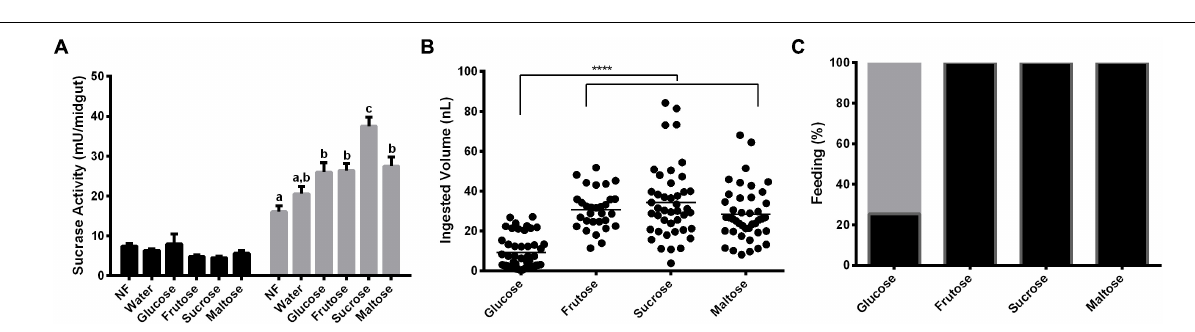
FIGURE 4 | Effect of feeding L. longipalpis females with different 1.2 M mono and disaccharides for 2 days on α -glucosidase activity. For each feeding condition midgut contents (black bars) and midgut tissues (gray bars) were analyzed (A) . The volume of mono or disaccharide solution ingested was also examined (B) . Representation of the percentage of females that ingested the mono or disaccharide solution. Fed females (black), unfed females (gray) (C) . Activity was measured using sucrose as substrate. NF – Recently emerged females (0–3 h), Water – females fed only with water for 2 days. The results are the mean ± SEM of three biological replicates each with n = 15. One-way ANOVA, followed by Tukey multiple comparison test. Different letters indicate statistically significant different groups, p < 0.05. ∗∗∗∗ indicates statistically significant differences in ingested volumes for different sugars, p <